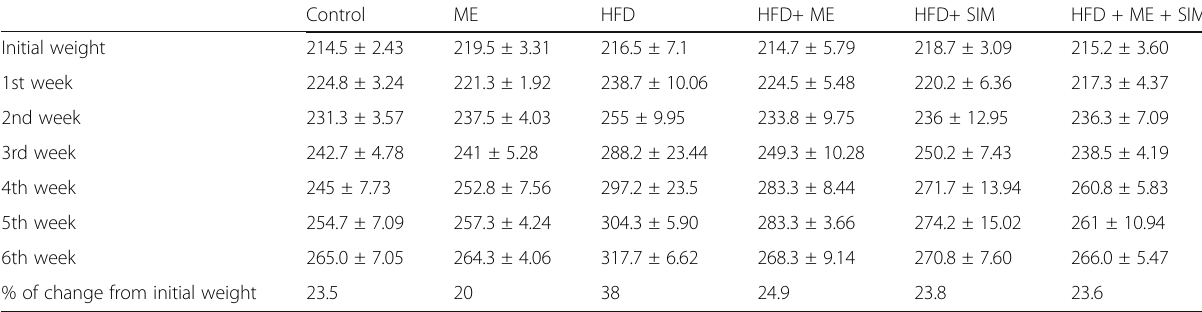
Table 1 The effects of Moringa leaf extract (ME), simvastatin (SIM) and their combination (ME+SIM) on body weight gain in rats fed a high-fat diet (HFD) for 6 weeks. ME controlled body weight gain and ameliorated obesity. All values are means ± SD ( n =